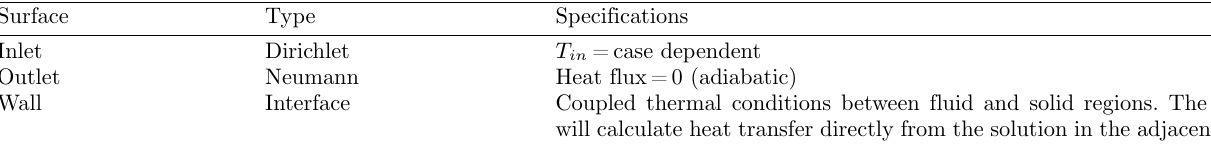
Table 3. Energy boundary conditions used for the fluid region.